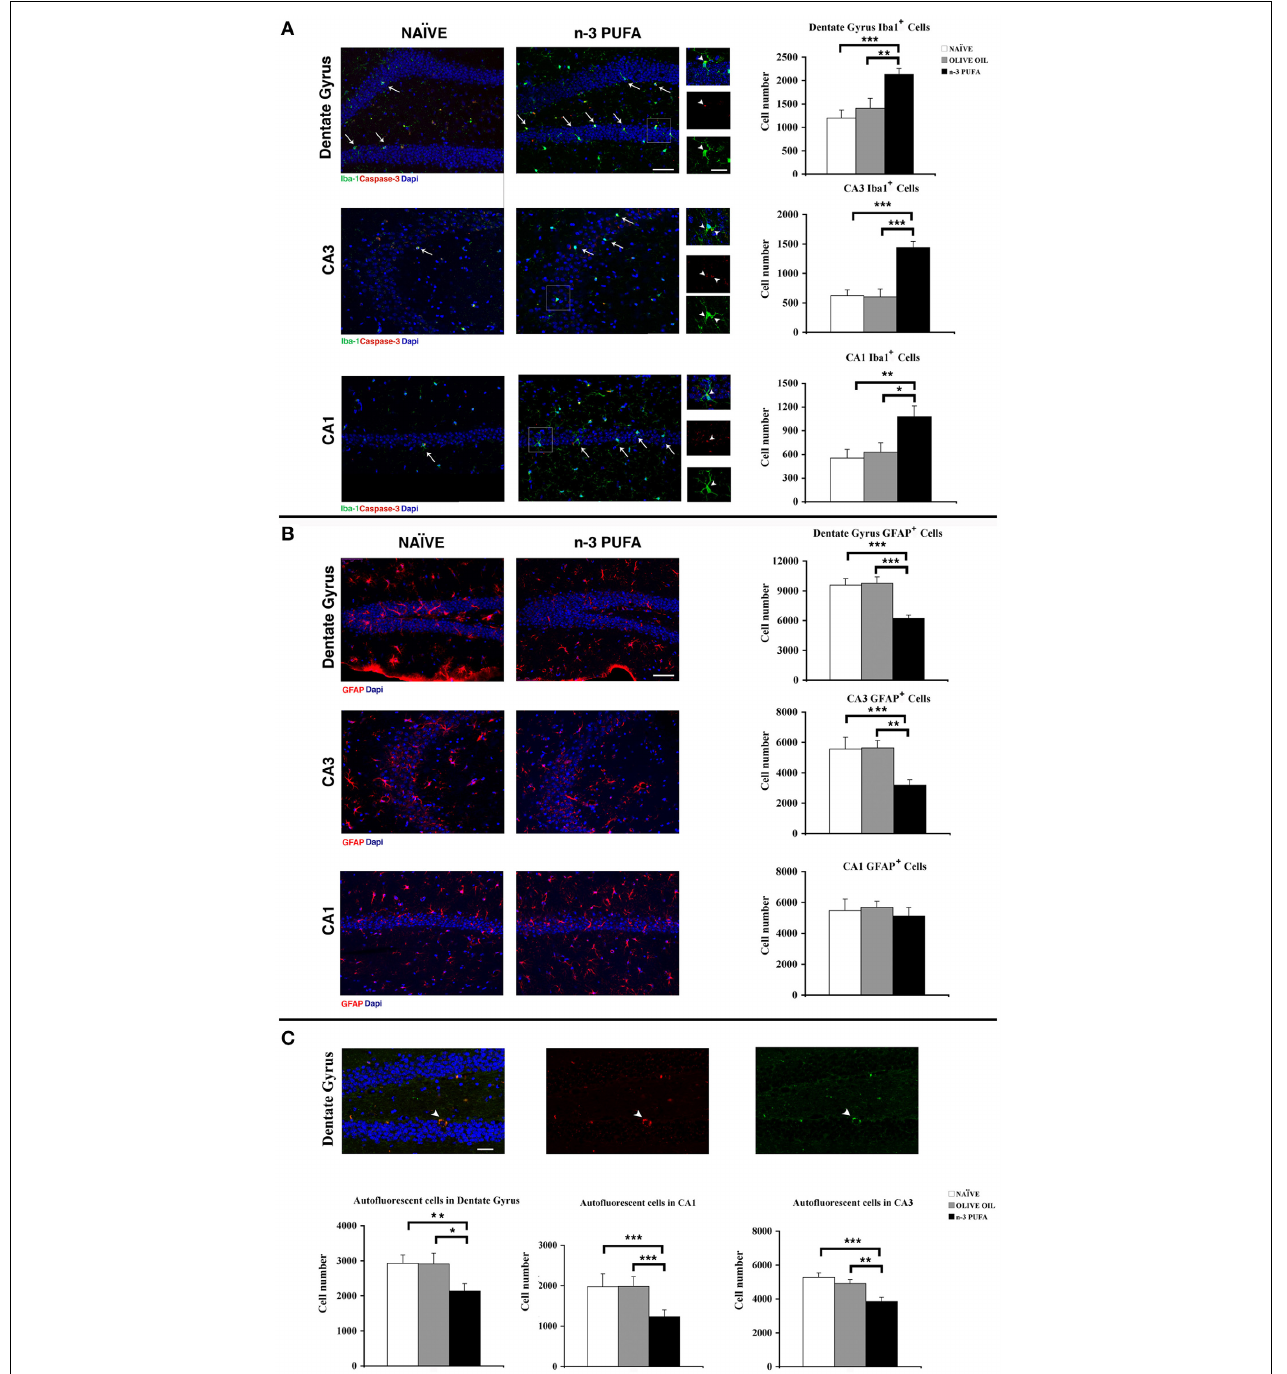
FIGURE 4 | n-3 PUFA effects on hippocampal glial populations and lipofuscin deposits. (A) Representative fluorescence images of confocal optical sections of Dentate Gyrus, CA3 and CA1 in NAÏVE and n-3 PUFA groups, showing Iba-1 + (green, arrows) and caspase-3 + (red) cells. Scale bar 50 μ m. In the central small panels, the higher magnifications (square boxes) show the neuronal caspase-3 + debris (red, arrowheads) phagocytated by the microglial cells (green, arrowheads). Scale bar 25 μ m. The histograms on the right show the Iba1 + cell number of the Dentate Gyrus, CA3 and CA1 in n-3 PUFA, NAÏVE and OLIVE OIL groups. (B) Representative fluorescence images of confocal optical sections